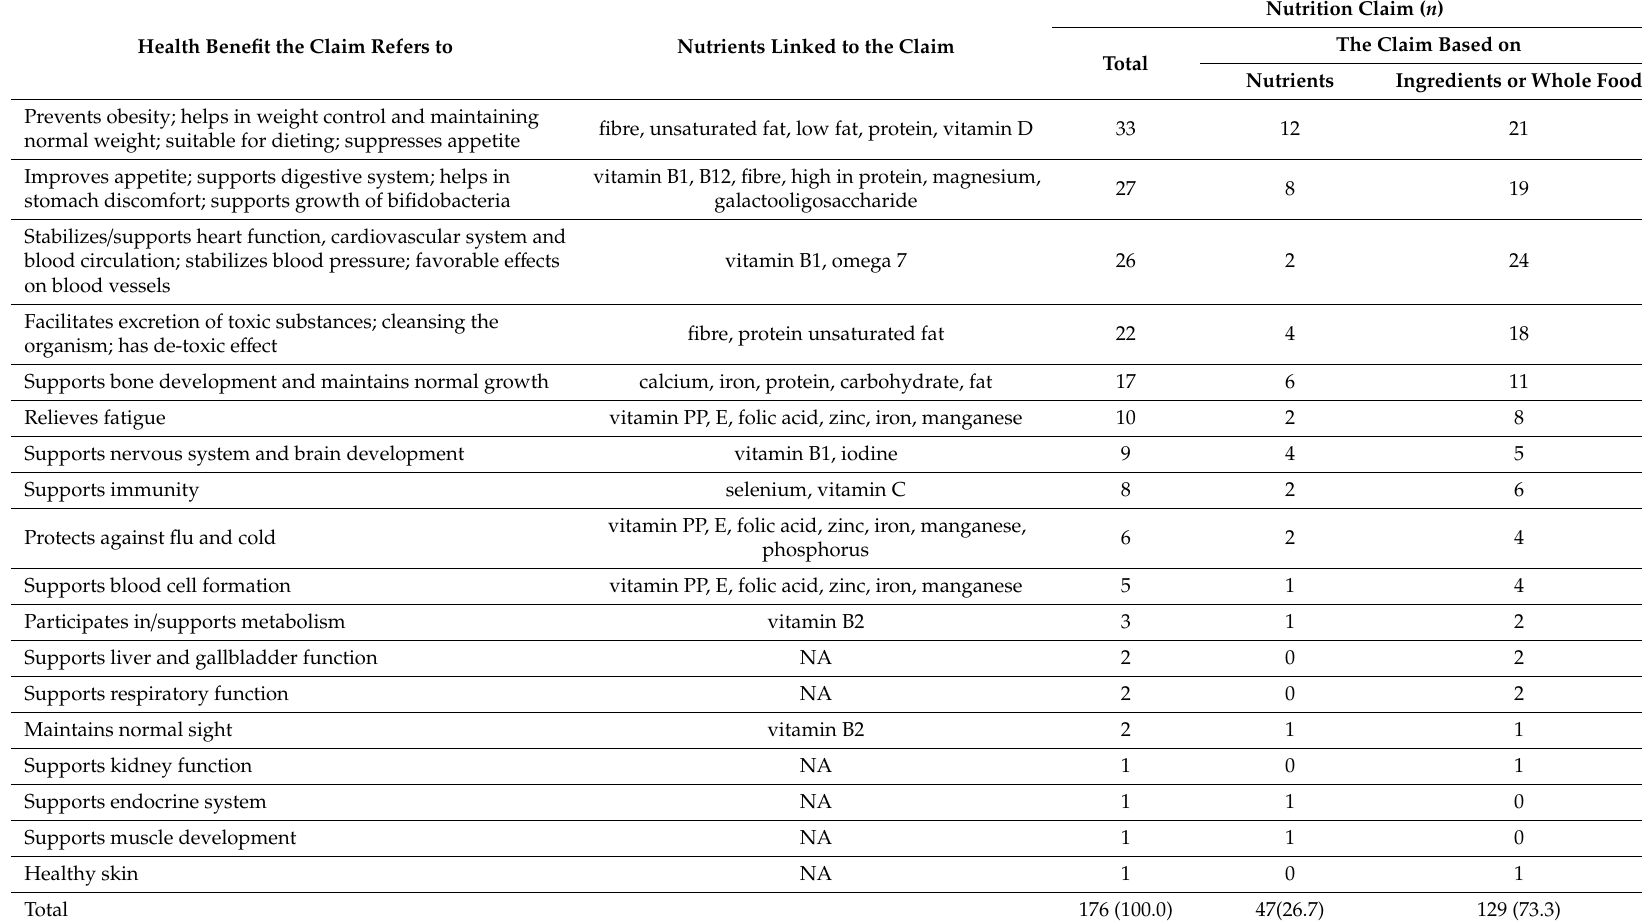
Table A2. Nutrient function claims by attributable health